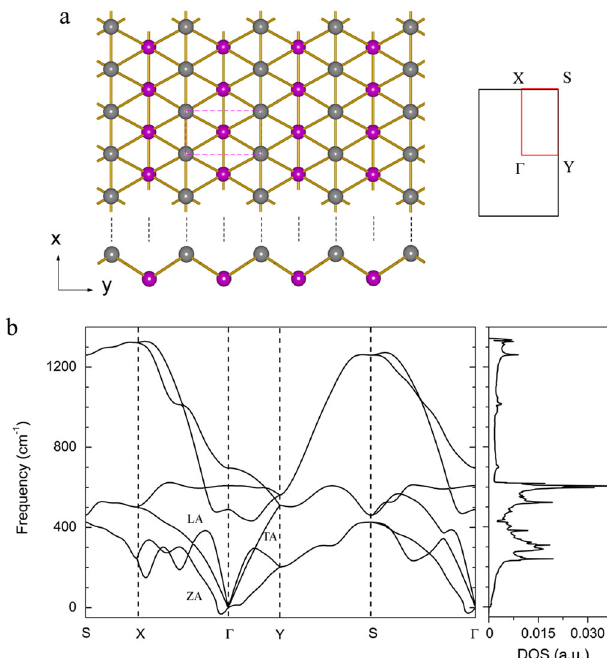
Fig. 1 Structure and phonon dispersion of hexagonal borophene. a The buckled crystal structure of borophene and the dashed lines show the unit cell. The atoms in upper and lower planes are represented by balls in gray and purple , respectively. The inset shows the Brillouin zone. b Phonon dispersion and density of states of borophene based on fi rst-principles